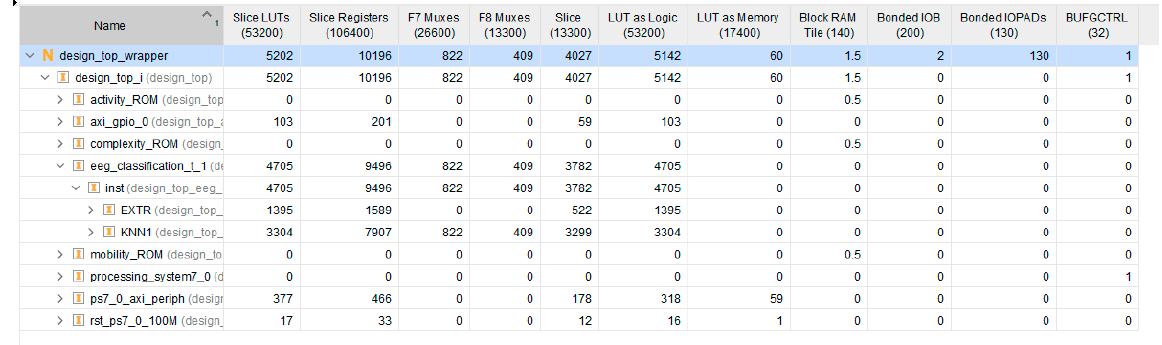
Figure 9. Logic source used for the proposed system implementation on Xilinx Zynq XC7Z030SBG485.